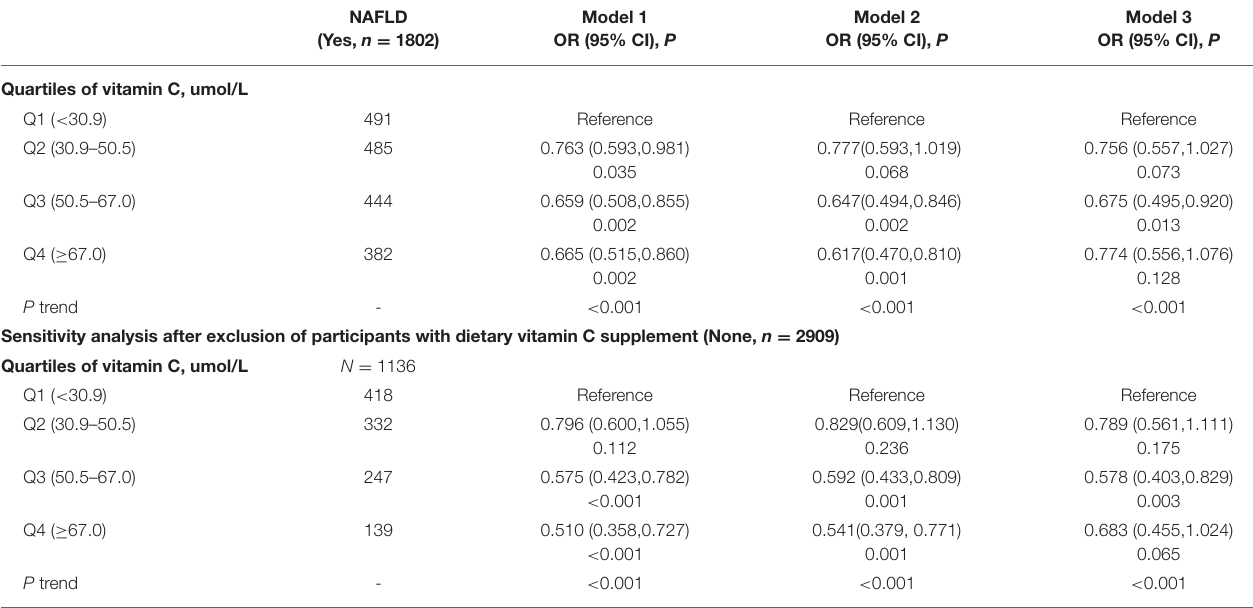
TABLE 2 | Associations between serum vitamin C level and NAFLD ( n = 4494), NHANES 2017–2018.